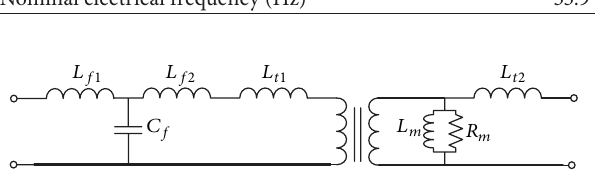
Figure 3: One phase equivalent circuit of the LCL filter and one tap of the tap